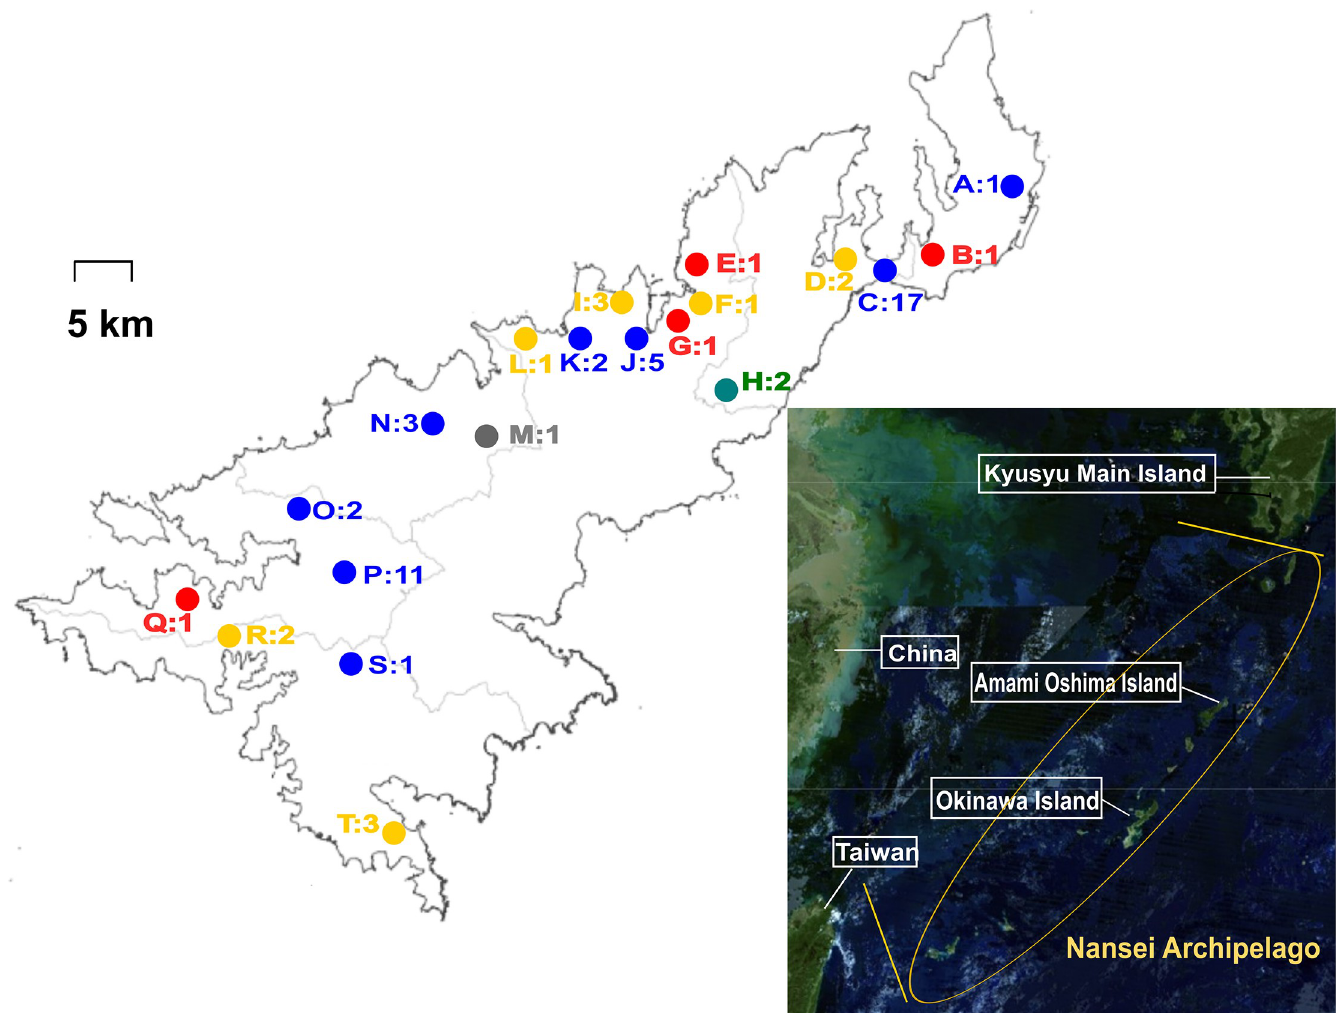
Fig 1. Sampling sites of wild and feral animals as well as places of residence of symptomatic dogs in this study. Circles indicate the sampling sites of wild and feral animals (A, C, D, F, H–P, and R–T) and places of residence of symptomatic dogs (B, E, G, and Q). Each color represents animal species: blue, black rats; yellow, Ryukyu wild boars; red, dogs; white, goats; gray, Amami rabbit. The numbers indicate the number of samples collected at each